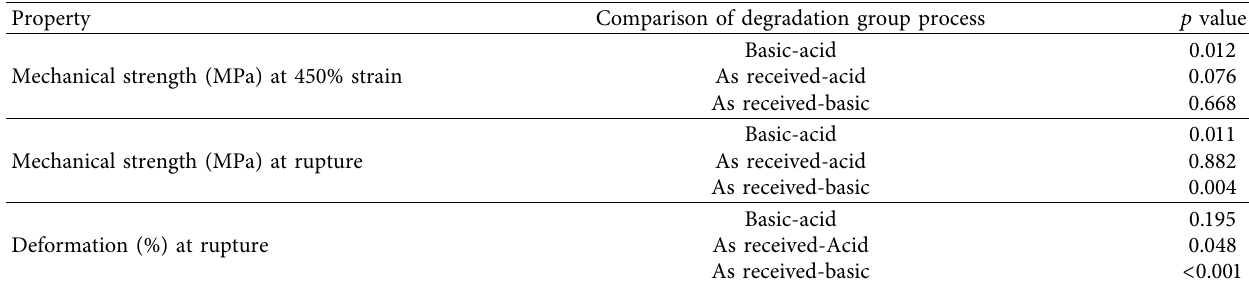
Table 5: Tukey’s test results from comparison of degradation process over mechanical properties.